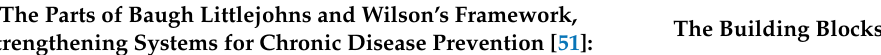
Table 2. Comparison between the elements of two prevention